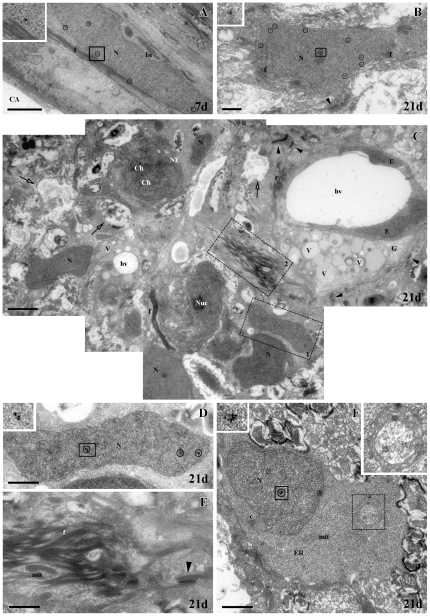
Immunogold electron microscopy labeling of Pax2 in the ONH.(all gold particles have been circled). (A) Pax2+ astrocyte with euchromatic nucleus (N) at 7 d post-injury. Inset: gold particle from the square. (B) Pax2+ astrocyte with euchromatic nucleus (N) at 21 d post-injury. Inset: gold particles from the square. (C) Composition of micrographs showing numerous glial cells (N: nucleus) among astrocyte processes with intermediate filaments (f), areas in degeneration (empty arrows) and dividing cells (ch: chromosomes) at 21 d post-injury. Close to the blood vessel (bv) there are granulocytes (G). Squares 1 and 2 are enlarged in D and E respectively. (D) Detail of a Pax2+ cell with a euchromatic nucleus (N). Inset: gold particles from the square. (E) Detail of intermediate filament packages (f). (F) Pax2+ astroblast with euchromatic nucleus (N). Upper left corner inset: gold particles from the bold square. Dotted square enlarged in upper right corner showing a doughnut-shaped mitochondria. Scale bars: A, C: 2500 nm; B, D–F: 1000 nm. Arrowheads: desmosomes; c: centrioles; CA: central artery; E: endothelium; ER: rough endoplasmic reticulum; f: intermediate filaments; In: indentations; mit: mitochondria; NE: nuclear envelope; Nuc: nucleolus; V: vesicles.